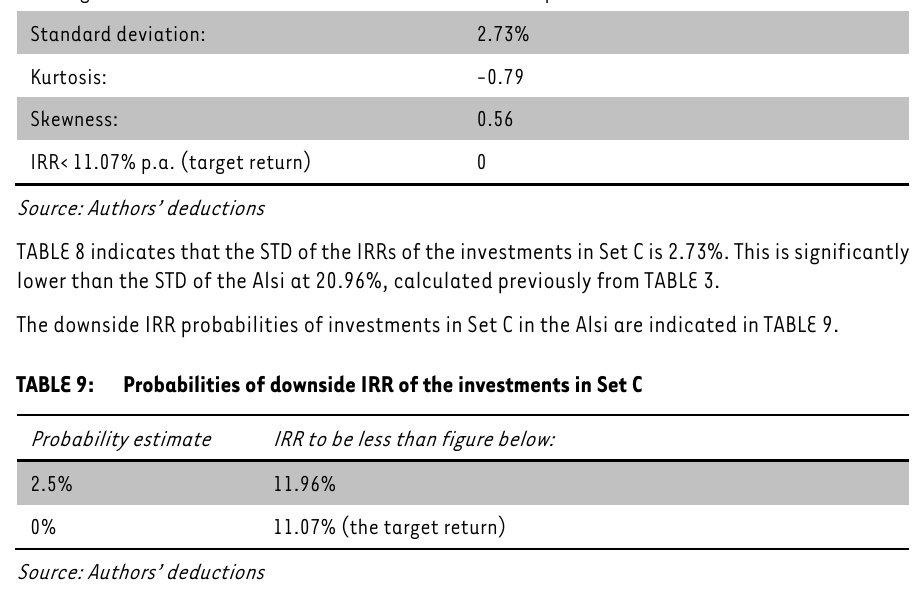
TABLE 8: Volatility of the IRRs of the investments of Set C Average IRR: